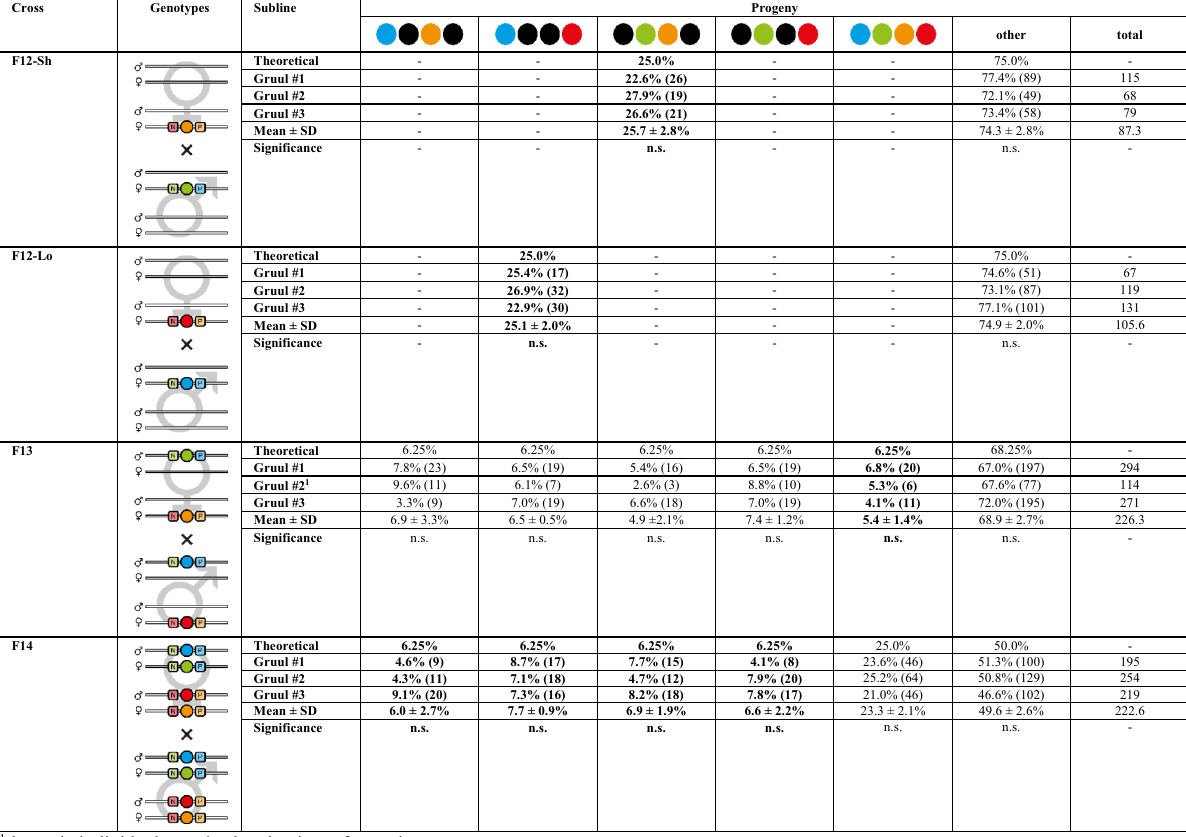
Table 2. Mating procedure results for the Gruul #1 to #3 hybrid sublines from the F12 to the F15 generation. Progeny that were used in the subsequent crosses are marked bold. The numbers in brackets and in the ‘total’ sub-column indicate the number of scored individuals. One-sample/two-tailed Student’s t-tests revealed no significant differences (n.s.) between the arithmetic means and the theoretical Mendelian ratios. 1 The male parent was dead at the time of